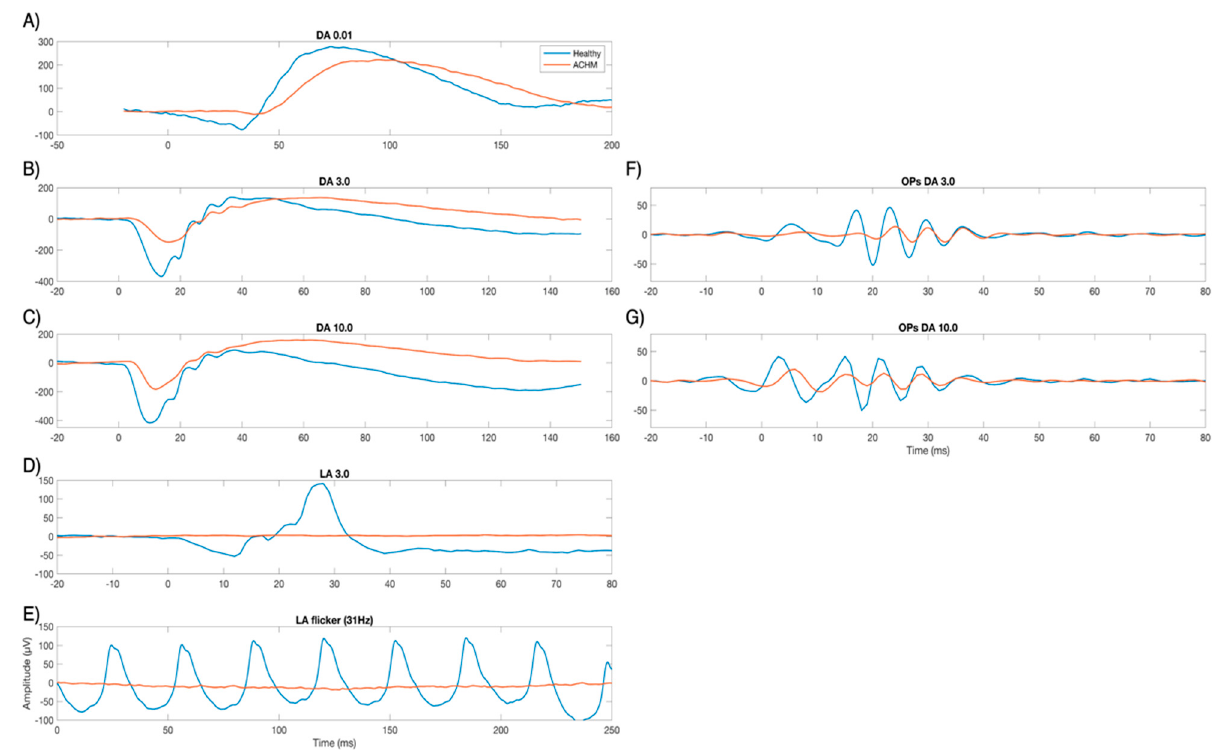
Figure 1. Full − field ERG according to the ISCEV (International Society for Electrophysiology of Vision) standards. Repre- sentative cases of one healthy control and one ACHM individual marked with blue and orange lines, respectively. On the left, the plots show standard responses of dark-adapted (DA) 0.01 ( A ), DA 3.0 ( B ), DA 10.0 ( C ), and light − adapted (LA) 3.0 ( D ) and LA flicker at 31 Hz ( E ). On the right panel, the plots ( F , G ) show the filtered traces (75–300 Hz) OPs of DA 3.0 and DA 10.0, respectively.